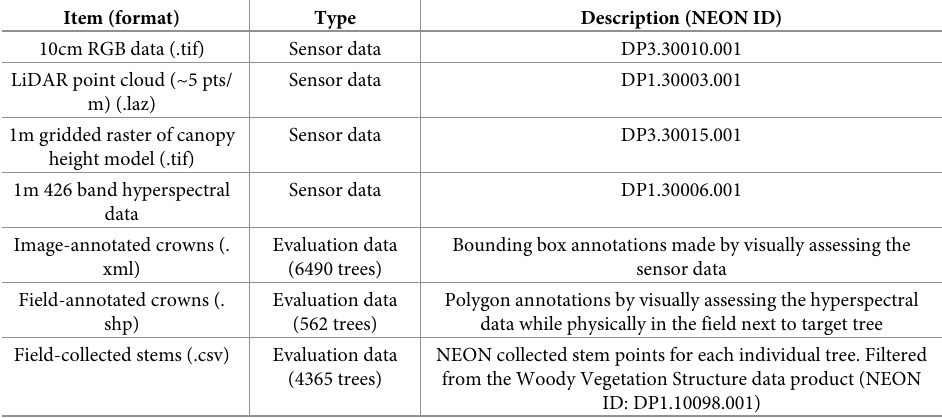
Table 1. Summary of datasets included in the benchmark dataset. All sensor data has been cropped to the extent of NEON field sampling